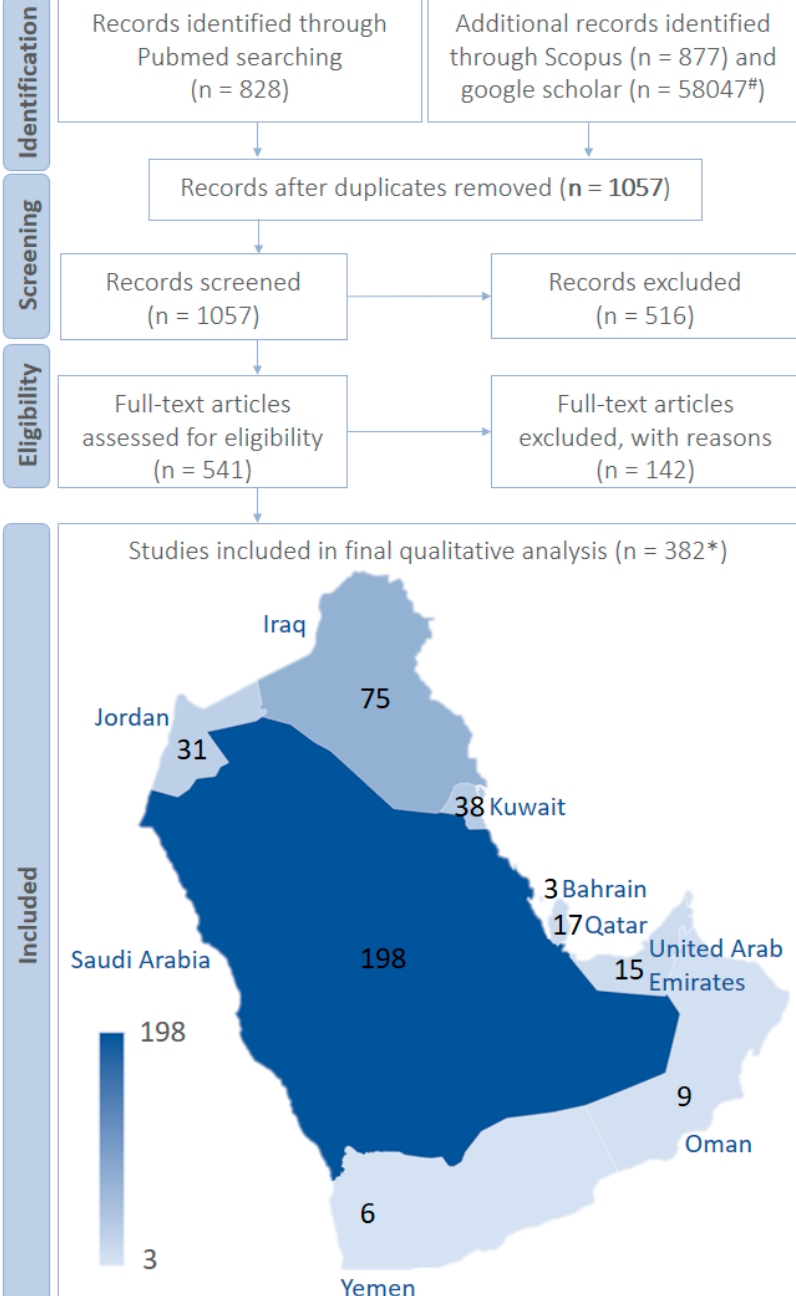
Figure 1. PRISMA 2009 flow diagram for the selection of articles reporting multi drug-resistant micro-organisms from the Arabian Peninsula, since 2010. * There were three papers reporting MDR micro-organisms in multiple countries [1]: Bahrain, Saudi Arabia and United Arab Emirates; [2]: Saudi Arabia, United Arab Emirates, Oman, Qatar, Bahrain, and Kuwait; [3]: Saudi Arabia, Kuwait, Oman and United Arab Emirates. # Google scholar not considered. Country-wise data for the number of articles from various databases are presented in Supplementary Table S1.